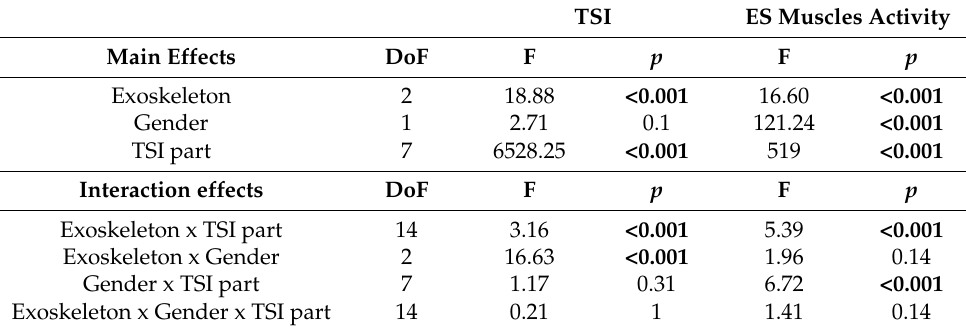
Table 1. Statistical fixed effects on TSI and ES muscle activity from the ANOVA. TSI ES Muscles